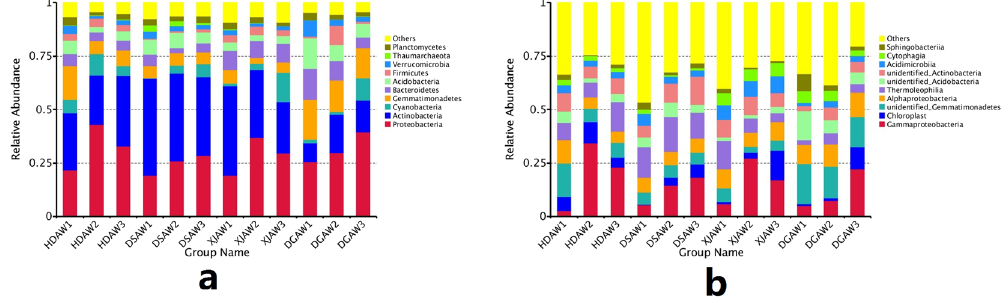
Figure 2. The relative abundance of the top ten phyla ( a ) and genera ( b ) in the Ferula rhizosphere. Abbreviations: HDAW, F. syreitschikowii ; XJAW, F. gracilis ; DSAW, F. ferulaeoides; and DGAW, F. lehmannii . The numbers indicate the root depth (1, 2, and 3 represent the 3, 20, and 40 cm depths,